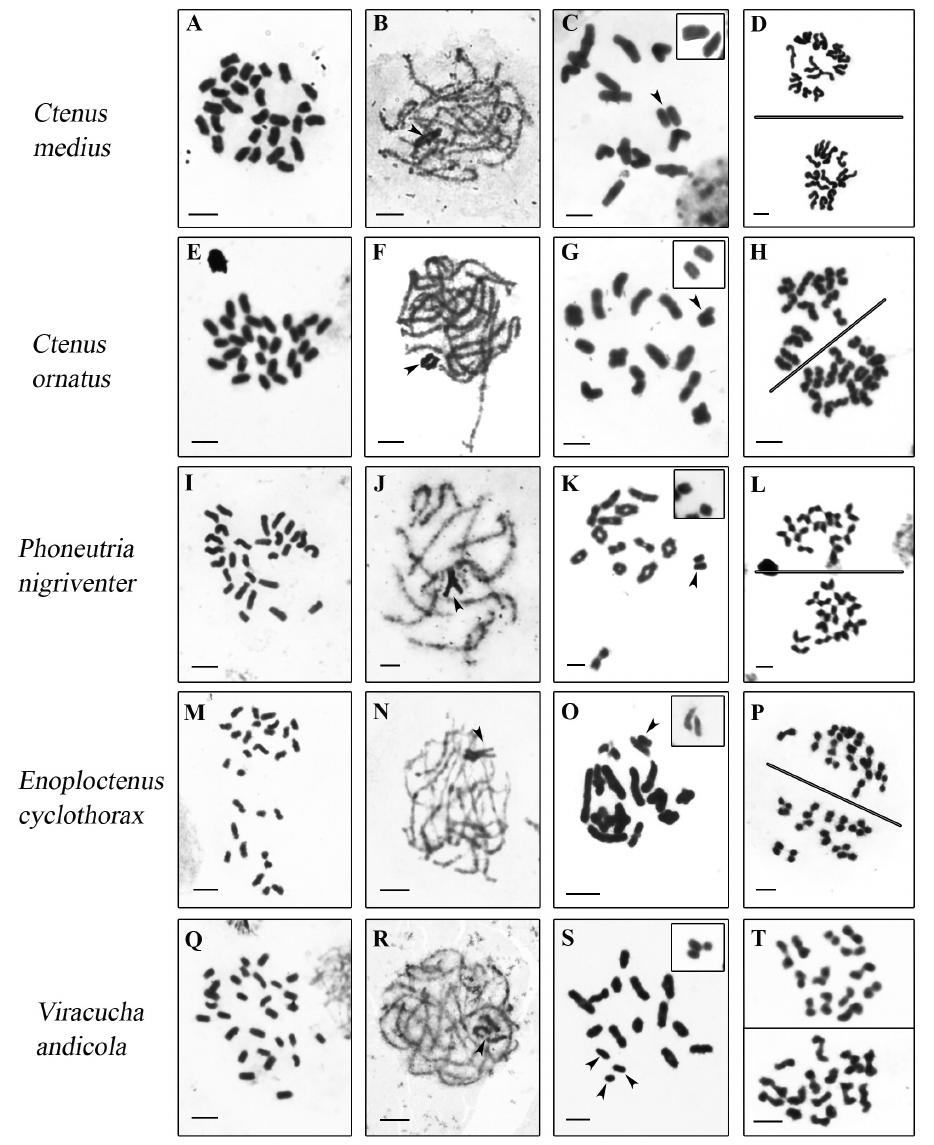
Figure 1. Male mitotic and meiotic cells of Ctenidae species stained with Giemsa. Boxes – X chromo- somes without association ( C, G, K, O ), and with association ( S ). C. medius ( A–D ), C. ornatus ( E–H ), P. nigriventer ( I–L ), E. cyclothorax ( M–P ), V. andicola ( Q–T ). The arrowheads show sex chromosomes. Mitotic metaphases with 2n = 28 ( A, E, I, M ) and 2n =29 ( Q ). Pachytene cells (B, F, J, N, R ) with posi- tively heteropycnotic sex chromosomes. Diakinesis cells ( C, G, K, O, S ), note parallel association of two X chromosomes ( C , G , K , O ) or three X chromosomes without association ( S ). Metaphase II cells with (D, H, L, P) and n = 13 and n = 13 + X (T) . Bar = 10 n = 13 and n = 13 + X X X X 1 2 1 2 3